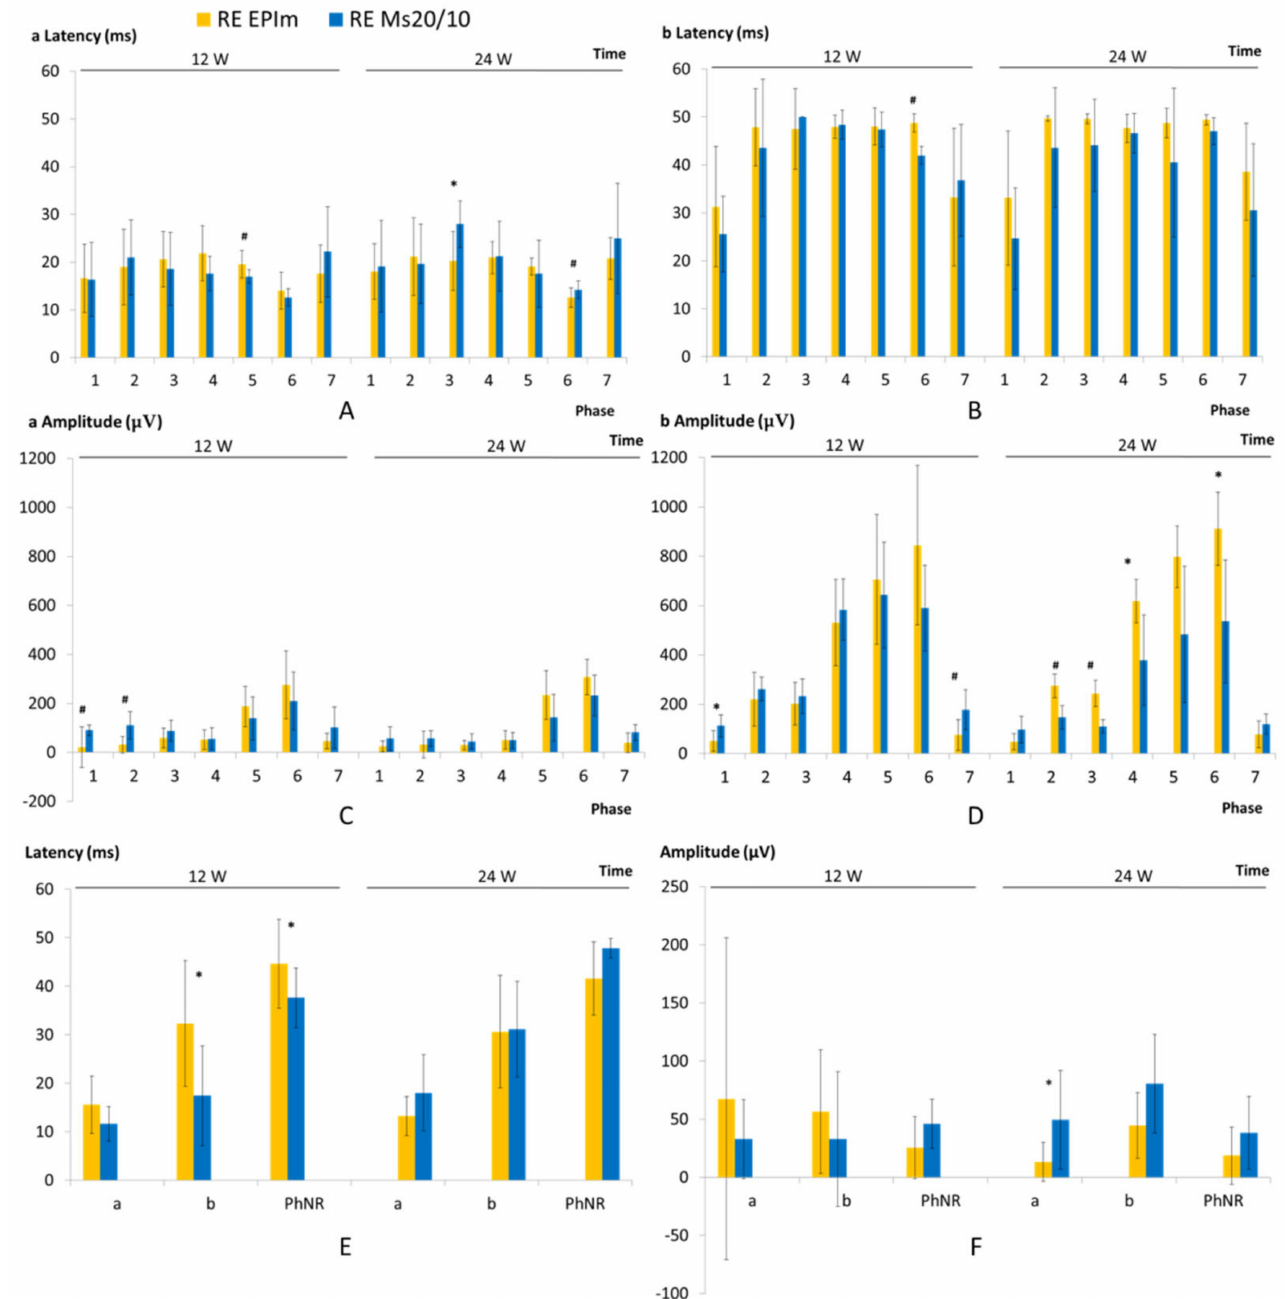
Figure 7. Comparison of functional neuroretinal measurements by electroretinogram between both ocular hypertensive models. Abbreviations: EPIm: episcleral sclerosis model; Ms 20/10: biodegradable microsphere 20/10 model. Scotopic electroretinogram: ERG. ( A ): latency of photorreceptors; ( B ): latency of intermediate cells; ( C ): amplitude of photoreceptors; ( D ): amplitude of intermediate cells; Rod response: phase 1. 0.0003 cds/m 2 , 0.2 Hz/s; phase 2: 0.003 cds/m 2 , 0.125 Hz/s; phase 3: 0.03 cds/m 2 , 8.929 Hz/s; phase 4: 0.03 cds/m 2 , 0.111 Hz/s; phase 5: 0.3 cds/m 2 , 0.077 Hz/s. Mixed rod-cone response: phase 6: 3.0 cds/m 2 , 0.067 Hz/s. Oscillatory potentials: phase 7: 3.0 cds/m 2 , 29.412 Hz/s explored by dark adaptation. PhNR: photopic negative response; ( E ): latency; ( F ): amplitude. a: a-wave expresses the functionality of photoreceptors; b: b-wave expresses the functionality of intermediate cells; PhNR-wave expresses the functionality of retinal ganglion cells. PhNR explored by blue light adaptation to a blue background (470 nm, 25 cds/m 2 ), and a red LED flash (625 nm, − 10 dB, 0.30 cds/m 2 , 1.199 Hz) as stimuli; w: week; ms: milliseconds; µ V: microvolts; *: statistical significance p < 0.05; #: statistical significance p < 0.02, for Bonferroni correction for multiple